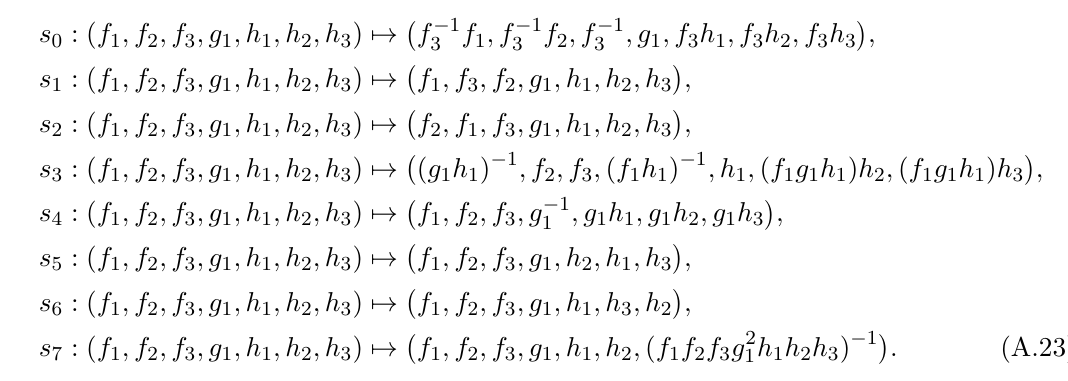
= s , s = s and s = s remain as symme- 07 0 s 7 16 1 s 6 25 2 s 5